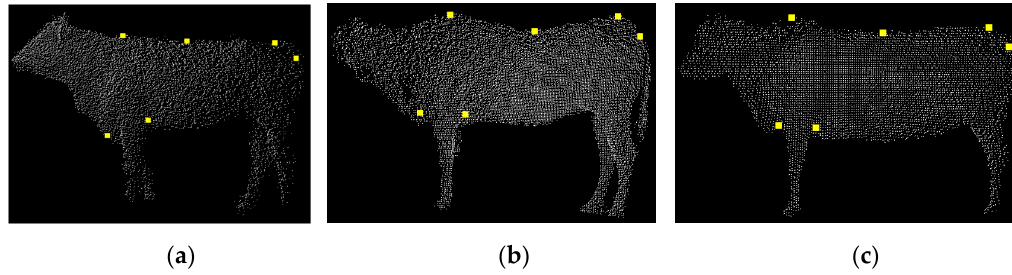
Figure 11. Recognition results of the feature points of three adult Qinchuan cattle: ( a ) Cattle Q0392; ( b ) Cattle Q0526; ( c ) Cattle Q0456.